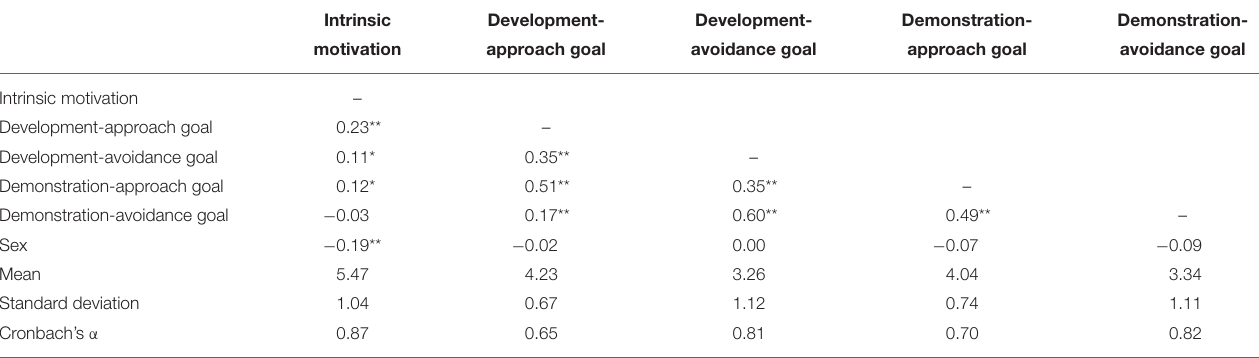
TABLE 3 | Study 2: intercorrelations and descriptive statistics.